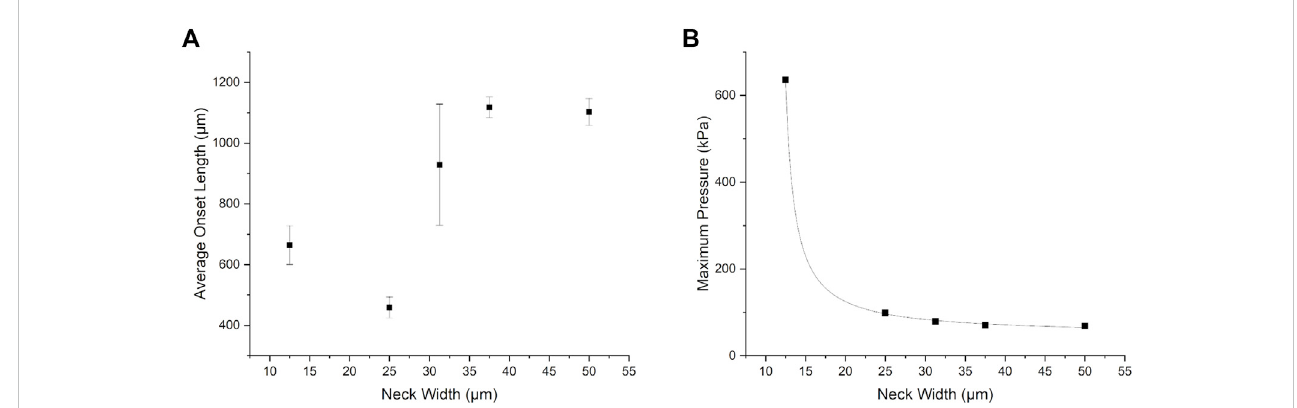
FIGURE 8 (A) Onset length and (B) maximum pressure as a function of neck width corresponding to a surface tension of 52 mN/m. Note that due to the large scatter in the datapoints for onset length no trendline is included. The error bars are the standard